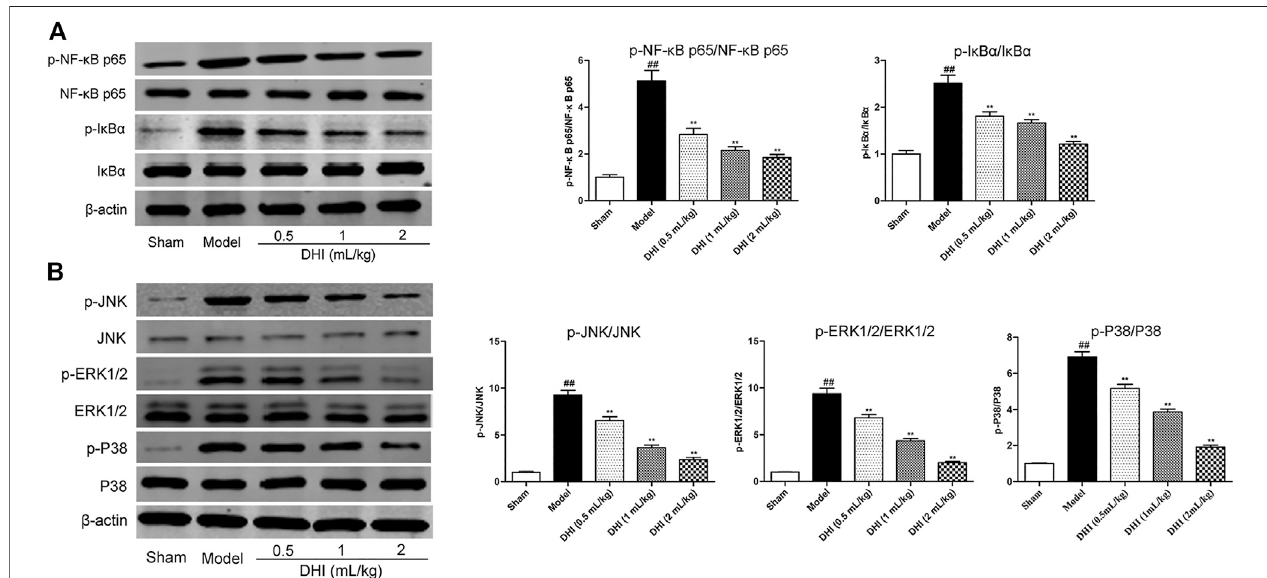
FIGURE 8 | Effects of DHI on the protein expressions of the phosphorylated and nonphosphorylated forms of key effectors related to the NF- κ B and MAPK signaling pathways by western blot analysis at 24 h after CIRI. (A) The representative bands of western blot in protein expressions of the phosphorylated and nonphosphorylated forms of NF- κ B p65, I κ B α , and β -actin in ischemic brain tissues; the quantitative analysis of protein expressions of p-NF- κ B p65/NF- κ B p65 and p-I κ B α /I κ B α ,respectively. (B) Therepresentativebandsofwesternblotinproteinexpressionsofthephosphorylated andnonphosphorylatedformsofJNK,ERK1/ 2, P38, and β -actin in ischemic brain tissues; the quantitative analysis of protein expressions of p-JNK/JNK, p-ERK1/2/ERK1/2, and p-P38/P38, respectively. Mean ± SD ( n (cid:2) 3). Asterisks denote the signi fi cant levels: ## P < 0.01 vs. sham group and * P < 0.05 and ** P < 0.01 vs. model group.